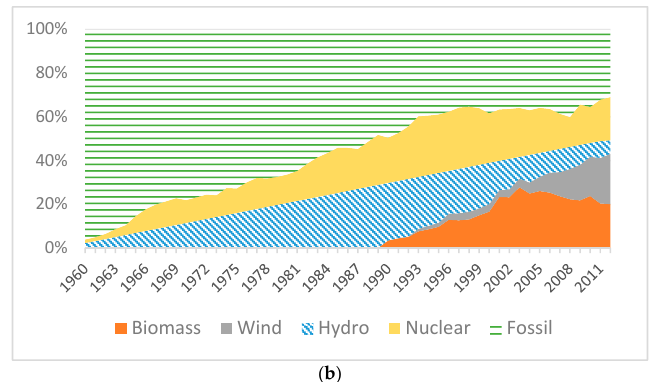
Figure 5. ( a ) Historical share of UK electricity inputs; ( b ) Inputs used in high renewable scenarios.